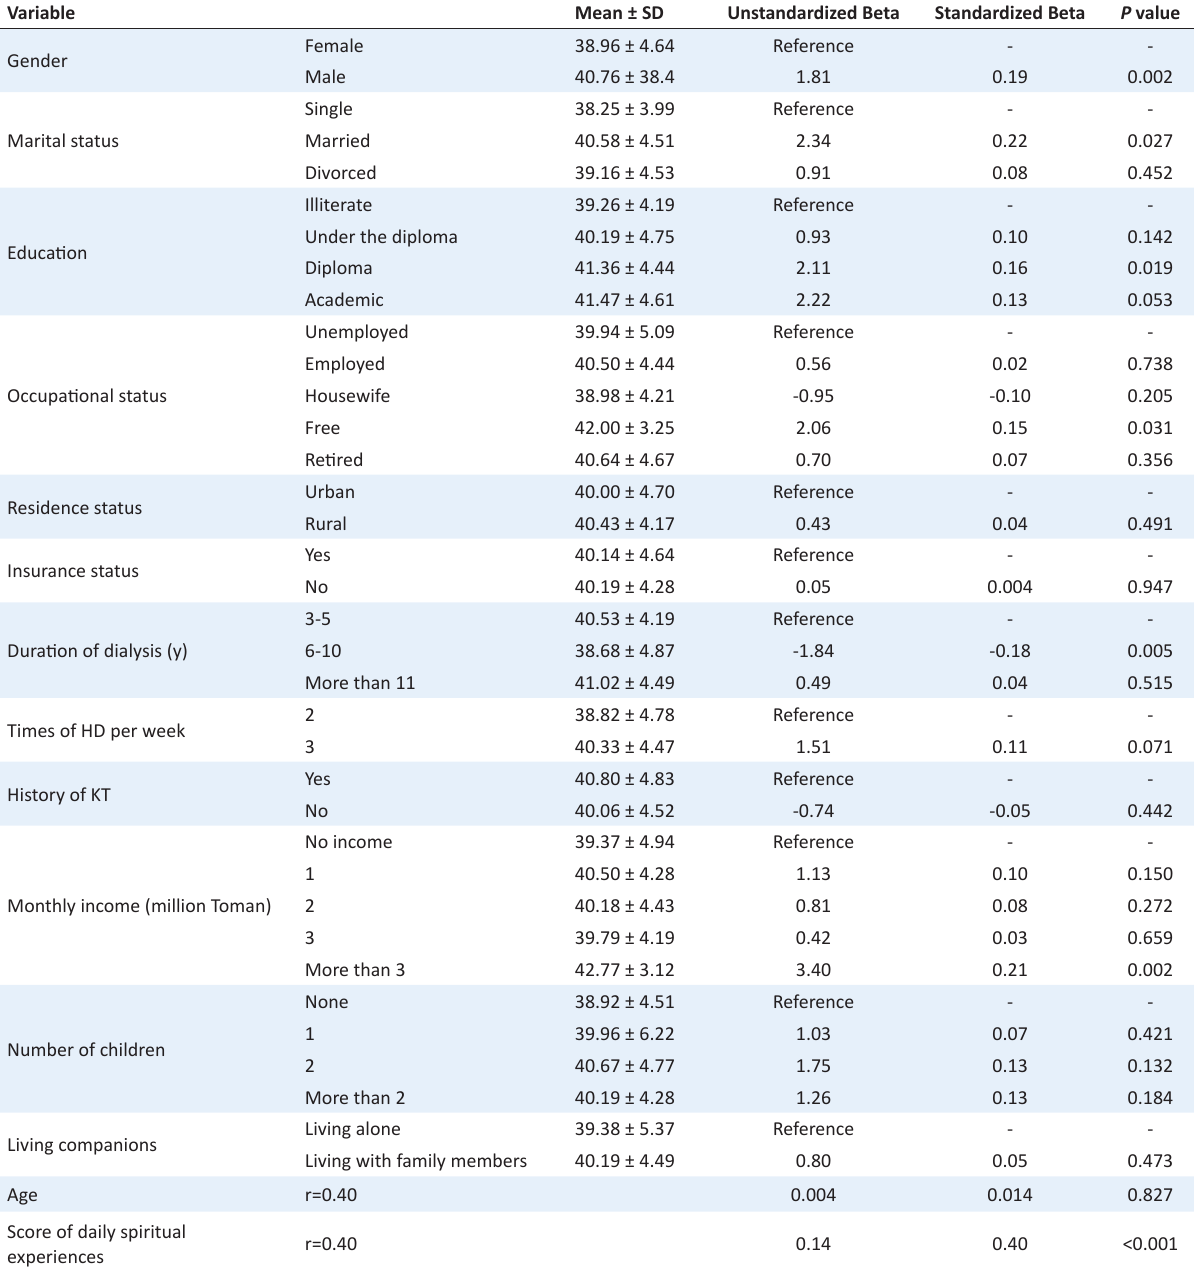
Table 2. Simple linear regression of the relationship between different variables and the level of hope in patients undergoing hemodialysis in Qazvin, Iran